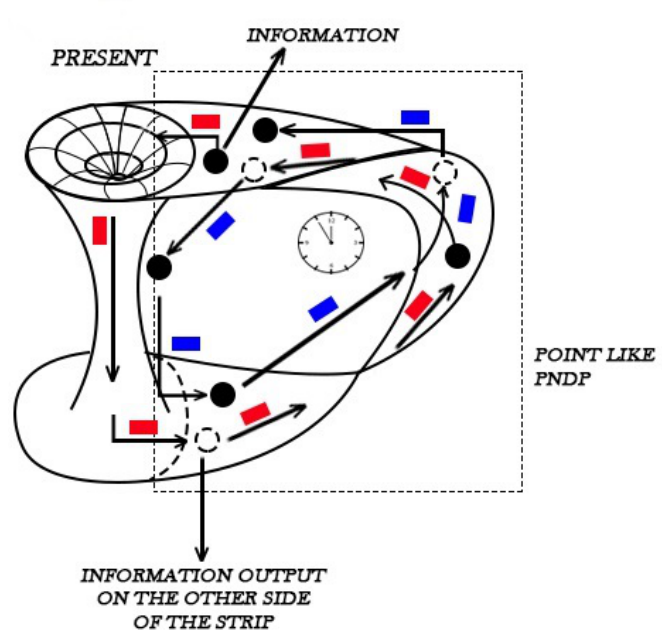
Figure 1. It shows a non-orientable wormhole which information enters the wormhole and takes a trip back in time. The red arrows indicate the information journey when it is making the first lap, while the blue arrows of the second lap are indicated to return to the correct side of the strip and, therefore, to be able to return to the wormhole entry instant. Then, all space time instants will be retraced from the past to the instant of the journey, but the fact that the information has to make a double tour, means that, in this parallel non-interacting universe, in which information is only a spectator, the time runs slower than an orientable wormhole. Within the dashed part we indicate that the non-orientable part of the wormhole a point-like PNDP, i.e., it emerges as a point, zero